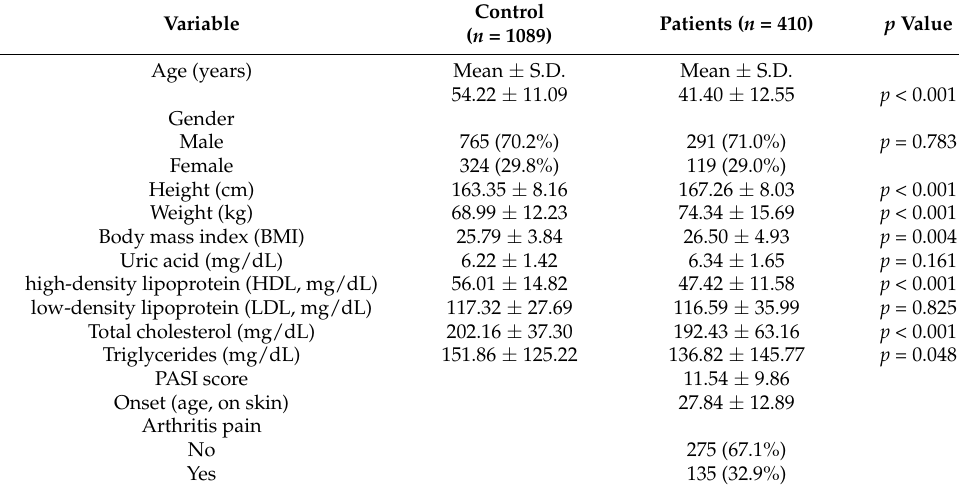
Table 1. Distributions of demographic characteristics of 1089 control and 410 patients with